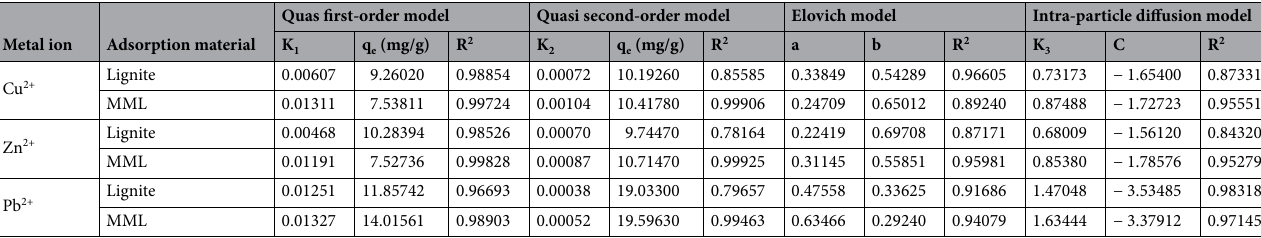
Table 2. Kinetic parameters of heavy metal ion adsorption on different samples: lignite;